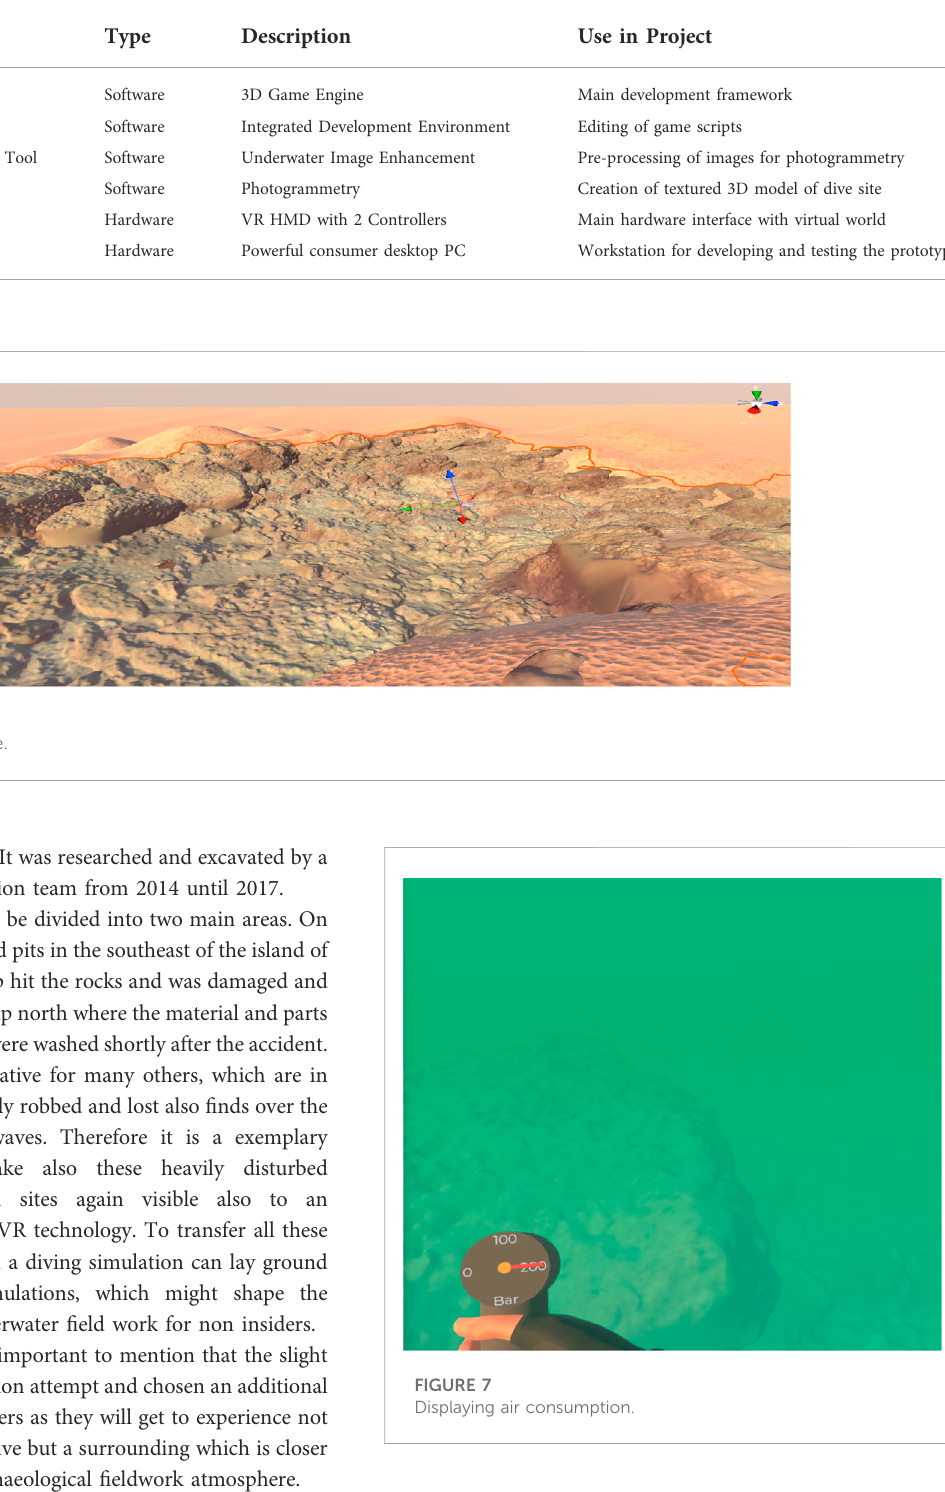
TABLE 1 List of the main frameworks and tools used in the creation of the